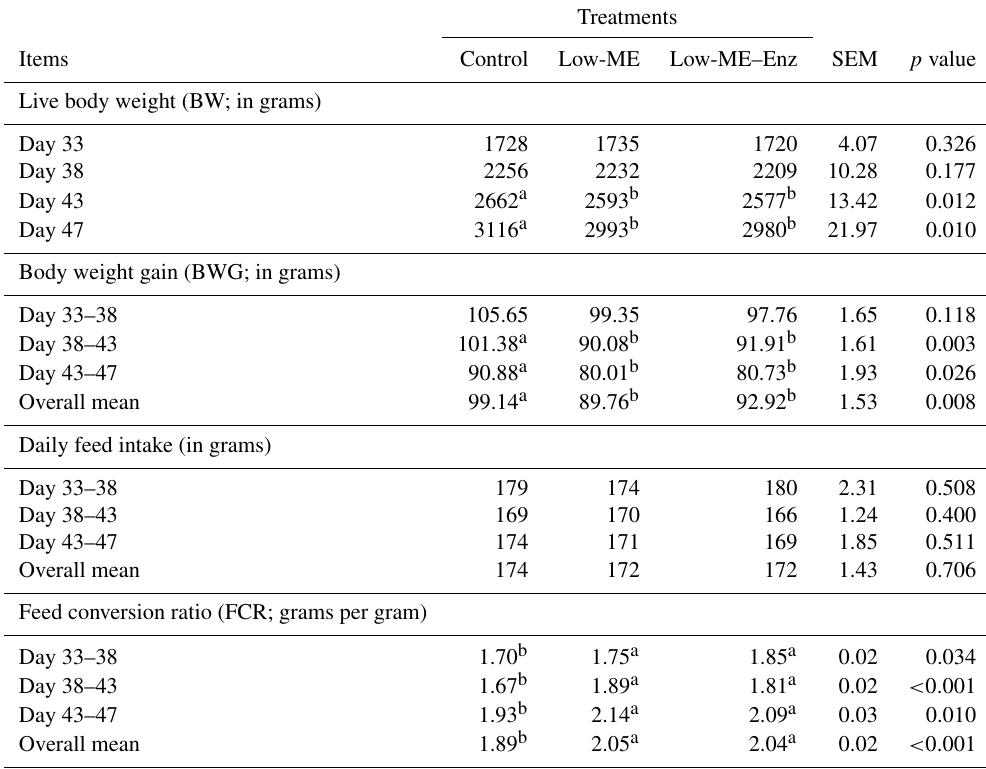
Table 2. Effects of dietary treatments on the growth performance of broiler chickens. Treatments Items Control Low-ME Low-ME–Enz SEM p value